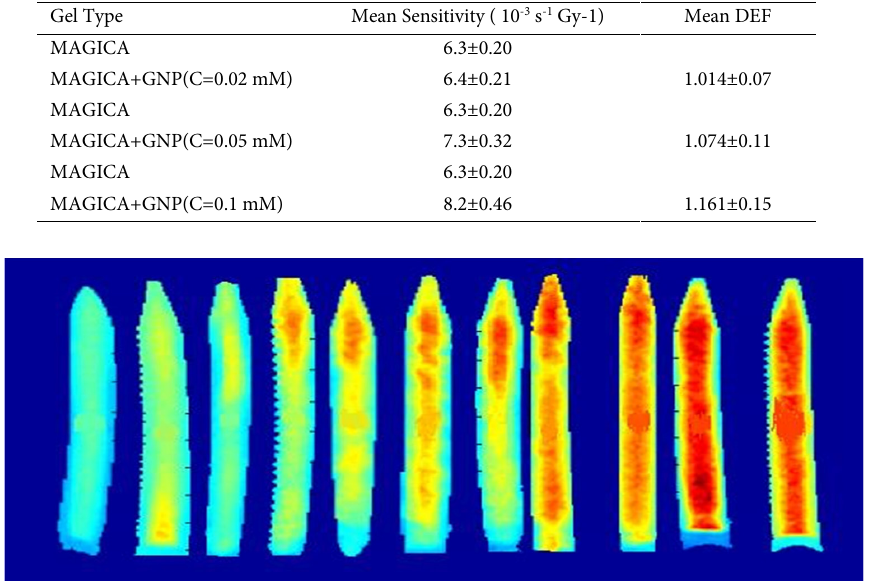
Fig. 2. The T2 map from MRI image of the gel samples Fig. 3